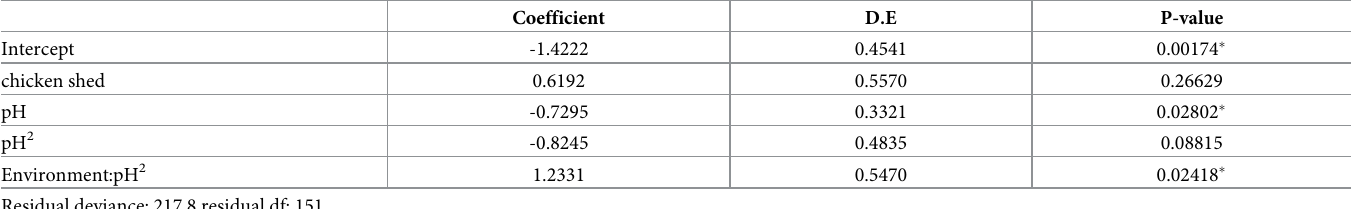
Table 6. Generalized linear mixed model of the variation of abundance in phlebotomine emergence at the quadrant level. The variables used in the model were envi- ronments (chicken shed and below house), pH and pH 2 . Significance: p < 0.05 � . Model: Abundance of newly emerged individuals ~ environment + pH + environment: pH2 + random effect